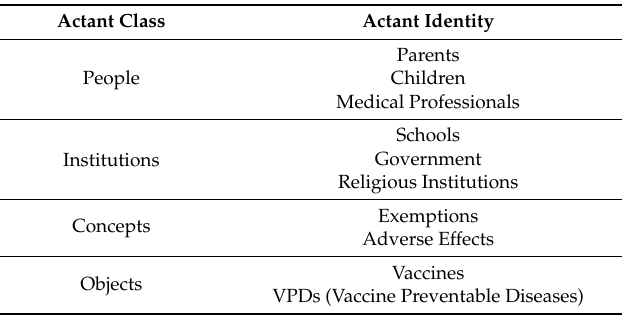
Table 1. Actants in the Vaccine Exemption Domain.